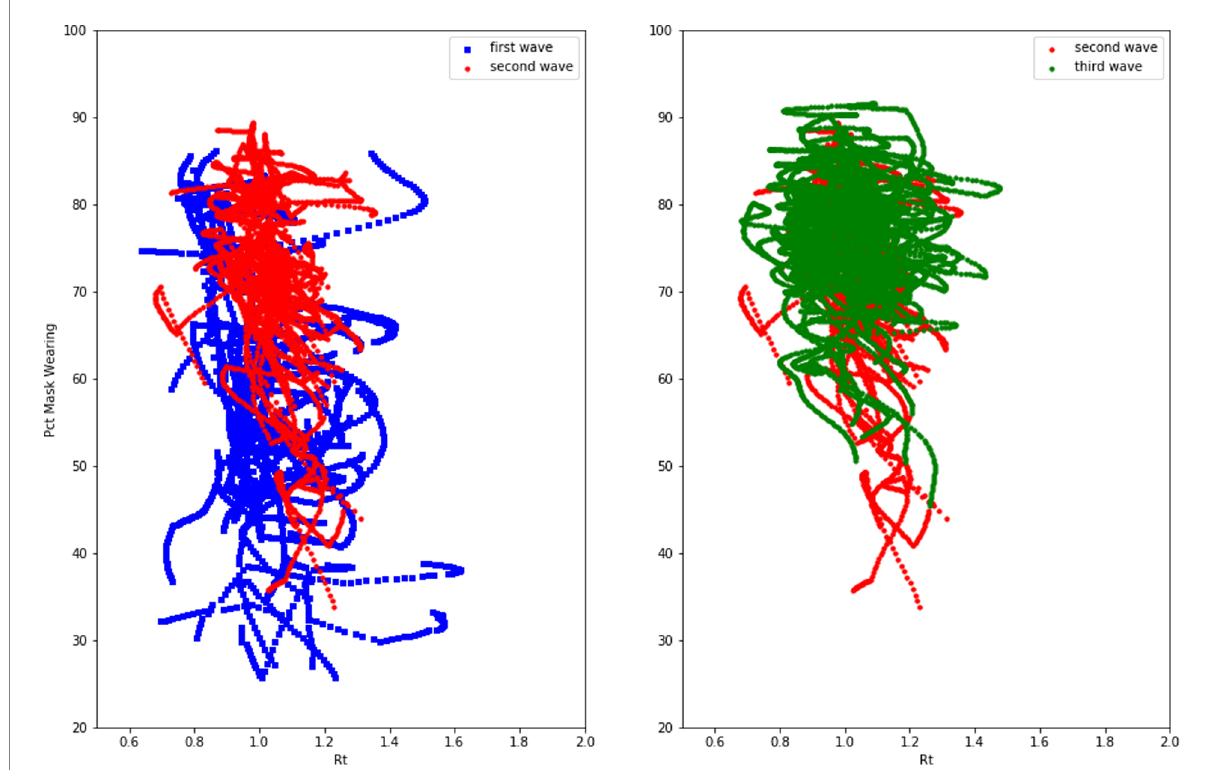
FIGURE 13 Scatter plot of mask wearing rates by Rt over three waves of COVD-19 in the United